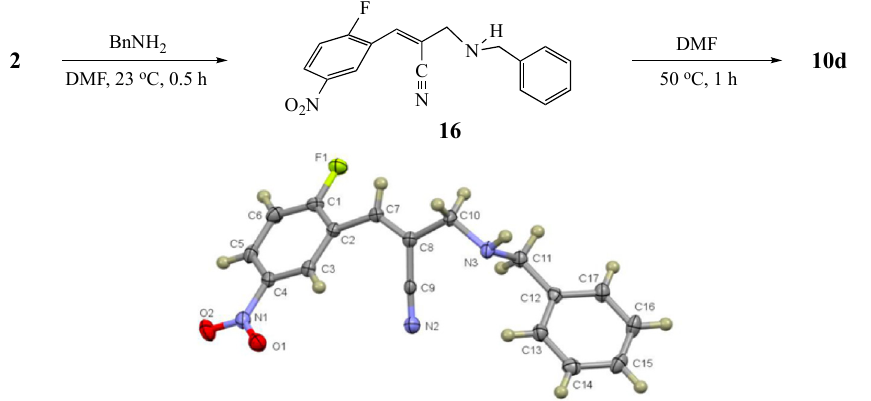
Figure 4. Control reaction for selective conjugate addition and formation of ( Z )-2-((benzylamino)methyl)-3-(2-fluoro-5-nitrophenyl)acrylonitrile ( 16 , CCDC 2035028) and its further conversion to 10d .